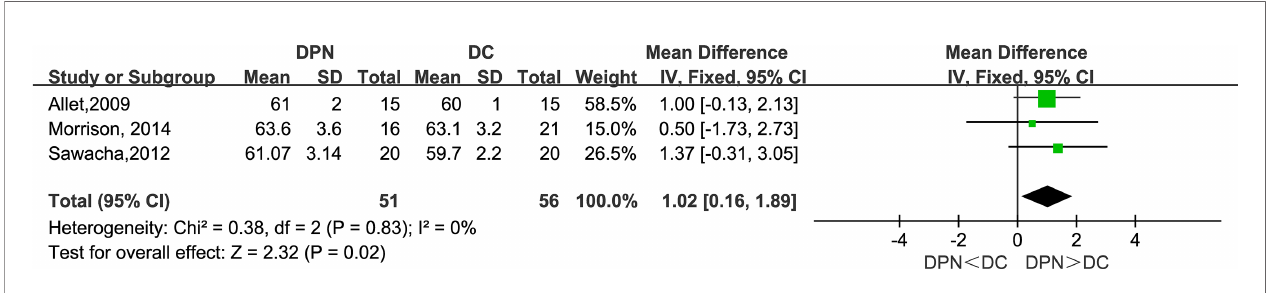
FIGURE 7 | Forest plot of stance time(%).